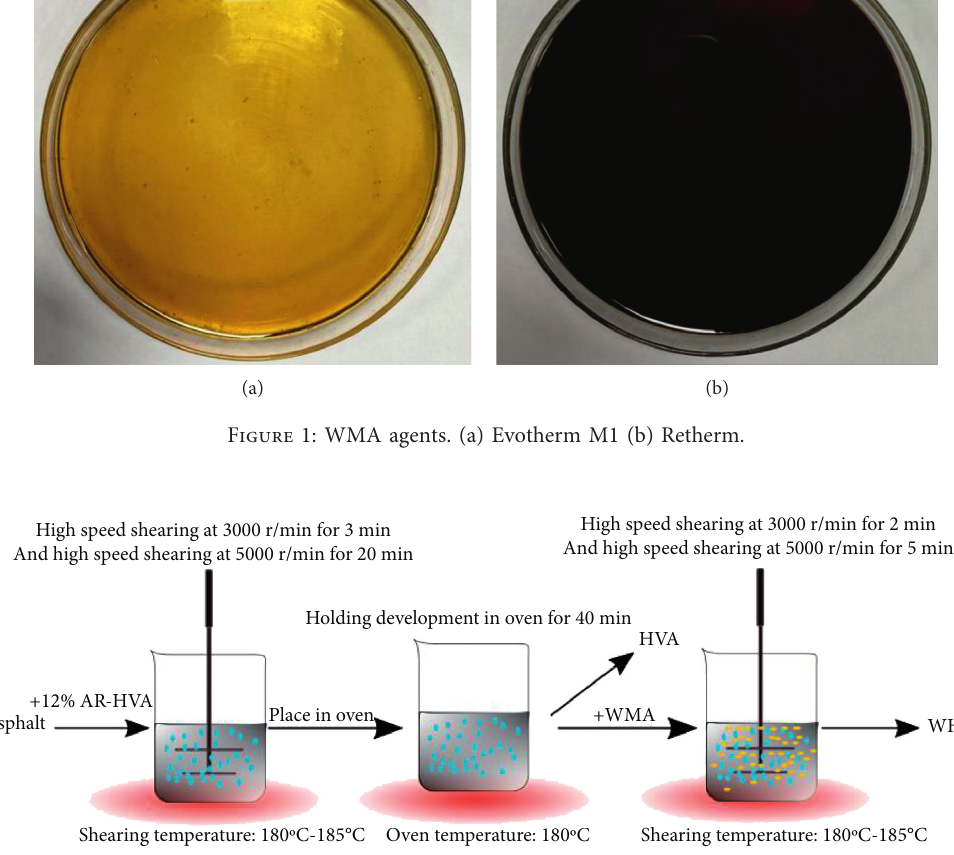
Figure 2: Preparation process of warm-mix